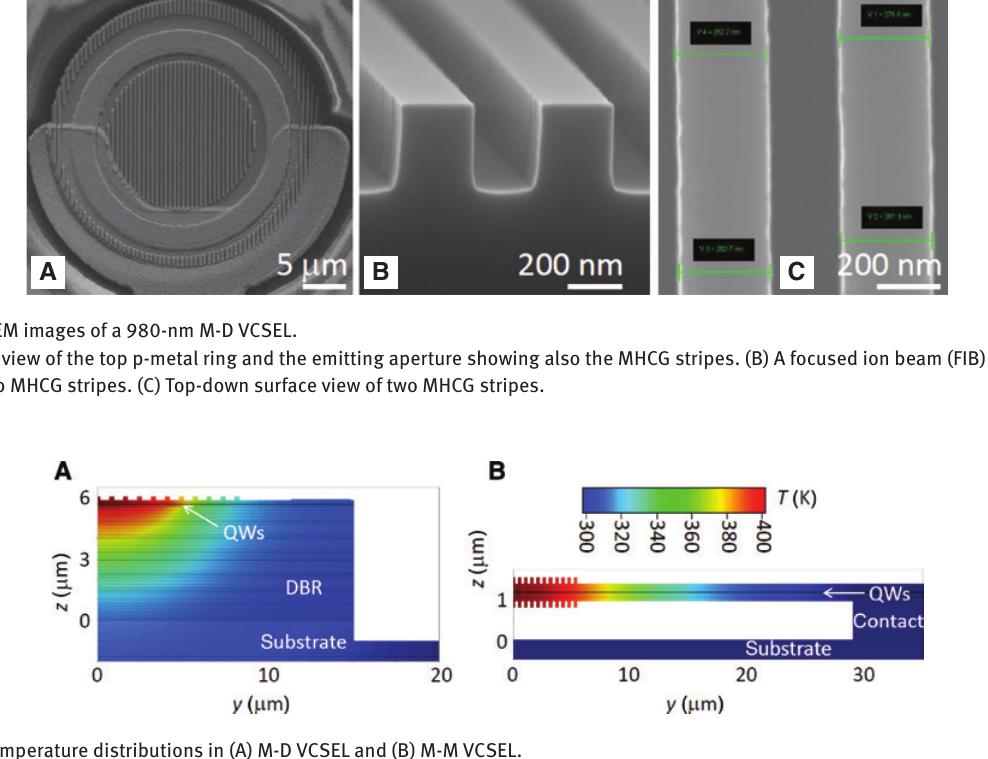
Figure 13: Temperature distributions in (A) M-D VCSEL and (B) M-M VCSEL. Temperature distribution generated in the device near rollover illustrated in the cross-sections of a half the structures. (A) An M-D VCSEL and (B) an M-M VCSEL. The 0 on the y -axis refers to the optical axis of the